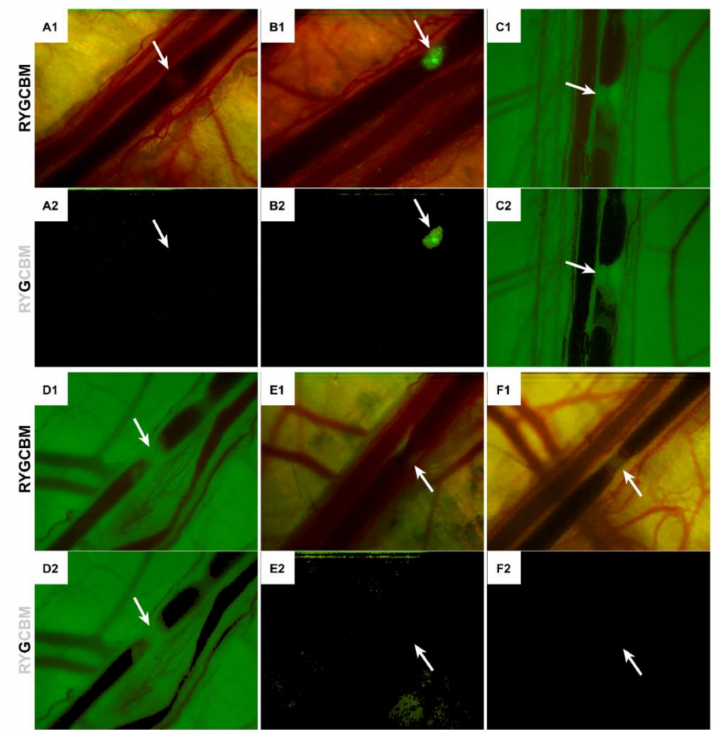
Figure 6. Intravital fluorescence imaging of laser-induced thrombi in hamster dorsal venules. ( A ) Negative control (no infusion of fluorophores); ( B ) positive control (FITC-labeled anti-CD62P monoclonal antibodies, 150 µ L of 0.5 mg / mL); ( C ) calcein (40 µ L of 49.6 mM); ( D ) CF (150 µ L of 3.4 mM); ( E ) CF-encapsulating DSPC:DSPE-PEG (96:4) LUVETs (400 µ L of 10 mM